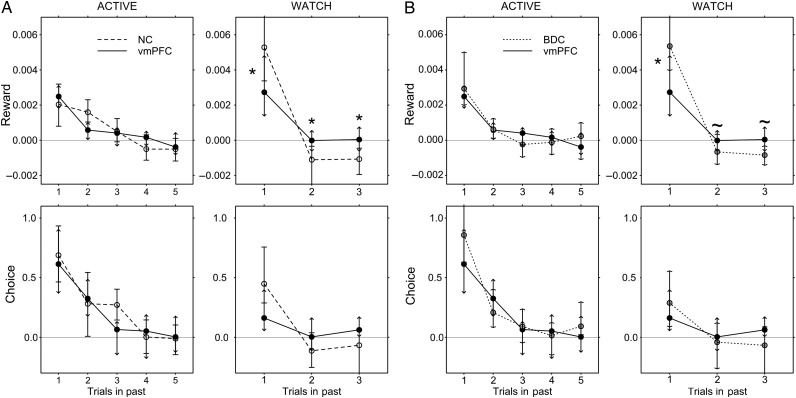
Results of logistic regression: Influence of previously experienced and observed rewards and choices on current behavior. (A) vmPFC and NC groups and (B) vmPFC and BDC groups. Experiential learning (“ACTIVE” trials: left-side panels): Top panels show influence of past rewards and bottom panels show influence of past participant choices on current behavior. x-axis refers to the number of trials in the past (e.g., Rewards: from the previous trial, t−1, until 5 trials in the past, t−5). Regression coefficients, for rewards (top panels) or choices (bottom panels), plotted on y-axis (solid line indicates the vmPFC group, and dashed line indicates the appropriate comparison group). For example, a reward coefficient of 0.003 relating to the t−1 trial indicates that the receipt of +100 points for choosing fractal A on the previous trial would increase the choice log odds of choosing fractal A on the current trial by 0.3 (i.e., 0.003 × 100). Similarly, a choice weight of 0.6 relating to the t−1 trial indicates that choosing fractal A on the previous trial would increase the log odds of selecting fractal A on the current trial by 0.6, above and beyond any reward received on the last trial (or, indeed, any rewards or choices relating to the computer player). See Materials and Methods for details. Observational learning (“WATCH” trials: right-side panels): Top panels show the influence of past observed rewards and bottom panels show the influence of past observed choices on current behavior. x-axis refers to the number of trials in the past (from the previous, t−1, trial until 3 trials in the past, t−3). Regression coefficients, for rewards (upper) or choices (lower panels), plotted on y-axis (solid line indicates the vmPFC group, and dashed line indicates the appropriate comparison group). For example, a reward coefficient of 0.004 relating to the t−1 trial indicates that if the “computer player” received a loss of −500 points for choosing fractal A on the previous WATCH trial, this would decrease the log odds of “the participant” choosing fractal A on the current ACTIVE trial by 2 (i.e., 0.004 × 500). Similarly, a choice weight of 0.4 relating to the t−1 trial indicates that if the computer player had chosen fractal A on the last WATCH trial, this would increase the log odds of the “participant” selecting fractal A on the current ACTIVE trial by 0.4, above and beyond any reward received by the computer on the last WATCH trial (and, indeed, any rewards received by the participant, or choices made by the participant). See Materials and Methods for details. Whiskers indicate BCa 95% confidence intervals [CIs; see DiCiccio and Effron (1996)]: Right-angle endlines are associated with CIs for comparison participants, and angled endlines with CIs for vmPFC participants. Note that overlapping BCa confidence intervals do not indicate nonsignificant differences; a better indicator of group differences is exclusion of the contrasting mean value from the interval. Symbols: *PBCa<0.05; ∼PBCa<0.10.